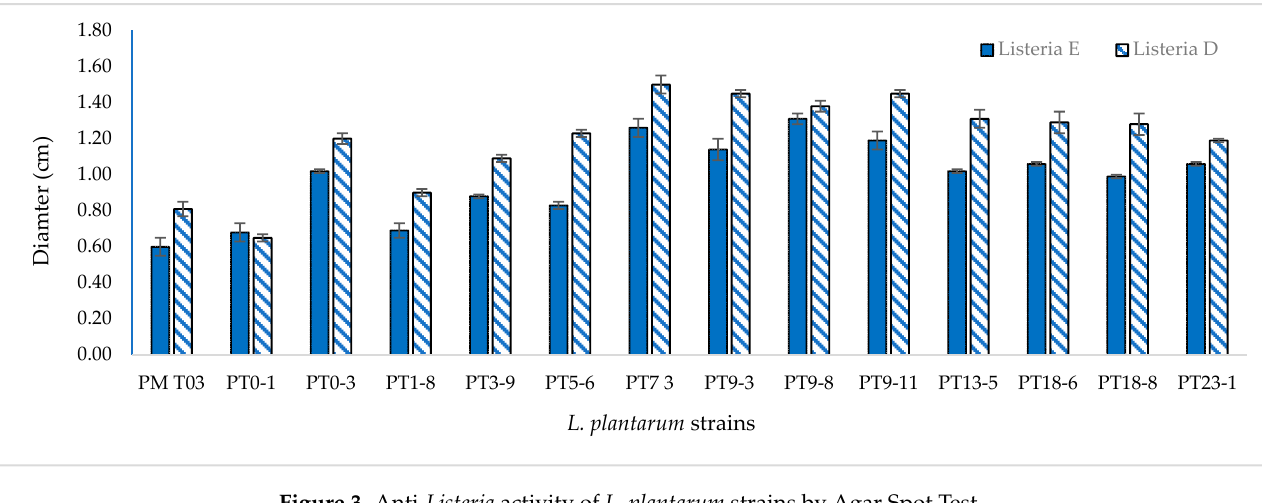
Figure 3. Anti-Listeria activity of L. plantarum strains by Agar Spot Test. Figure 3. Anti- Listeria activity of L. plantarum strains by Agar Spot Test.